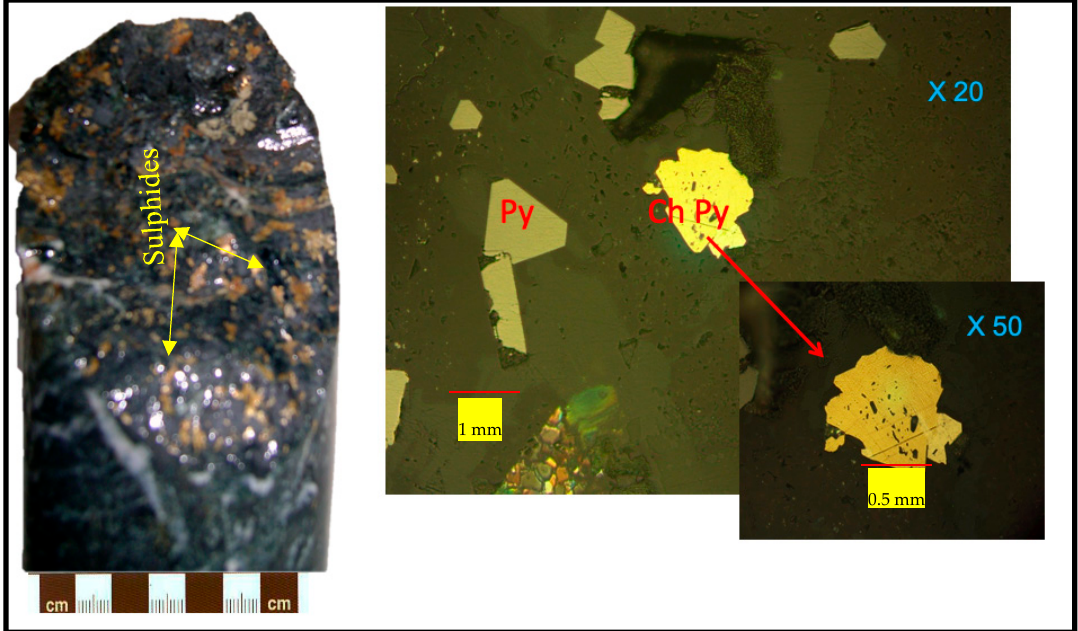
Figure 9. The drill core with sulphides, and petrography reveals Pyrite (Py) and Chalcopyrite (Chpy).